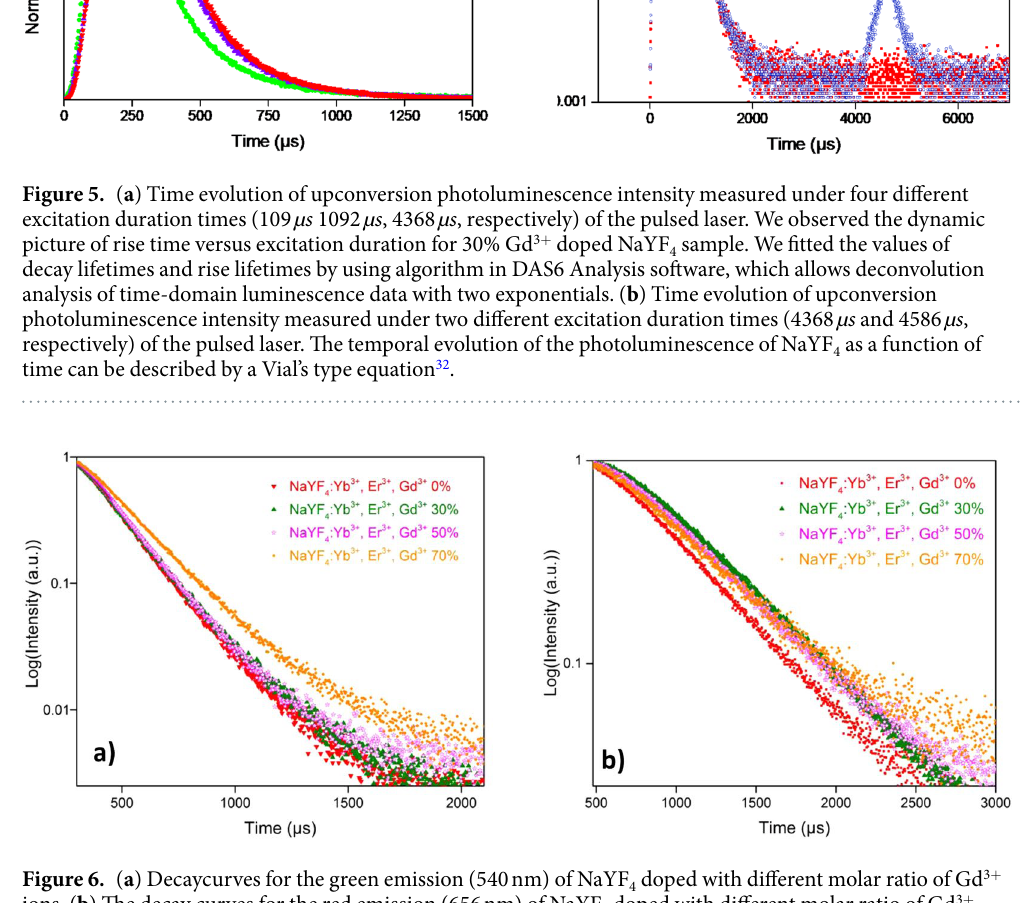
Figure 6. ( a ) Decaycurves for the green emission (540 nm) of NaYF 4 doped with different molar ratio of Gd 3 + ions. ( b ) The decay curves for the red emission (656 nm) of NaYF 4 doped with different molar ratio of Gd 3 +